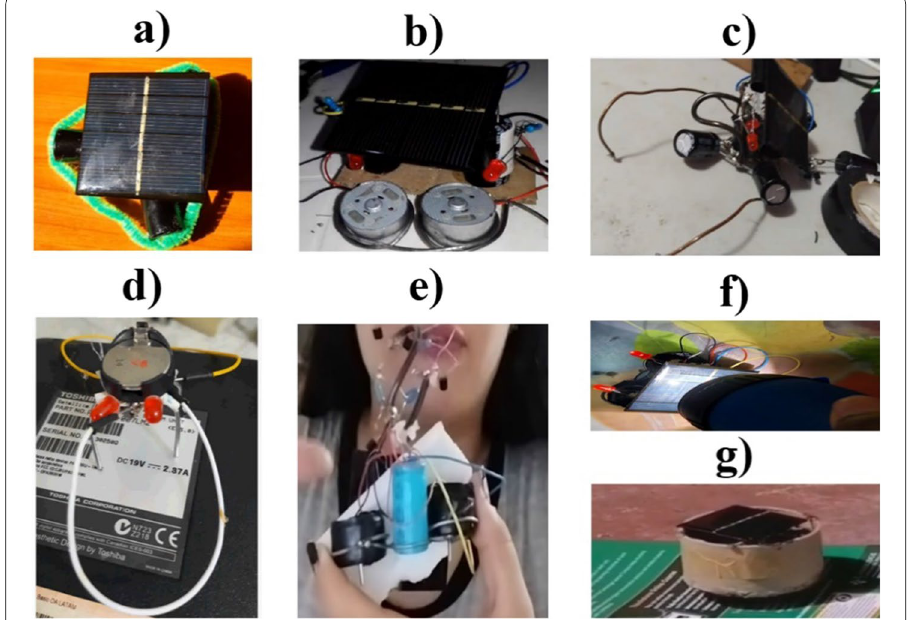
Fig. 16 Robots were built in the last module. a SYMMET robot with a plastic frame for, instead of metal. b PHOTOPOPPER robot with a cardboard structure to integrate all the parts. c SYMMET robot with metal